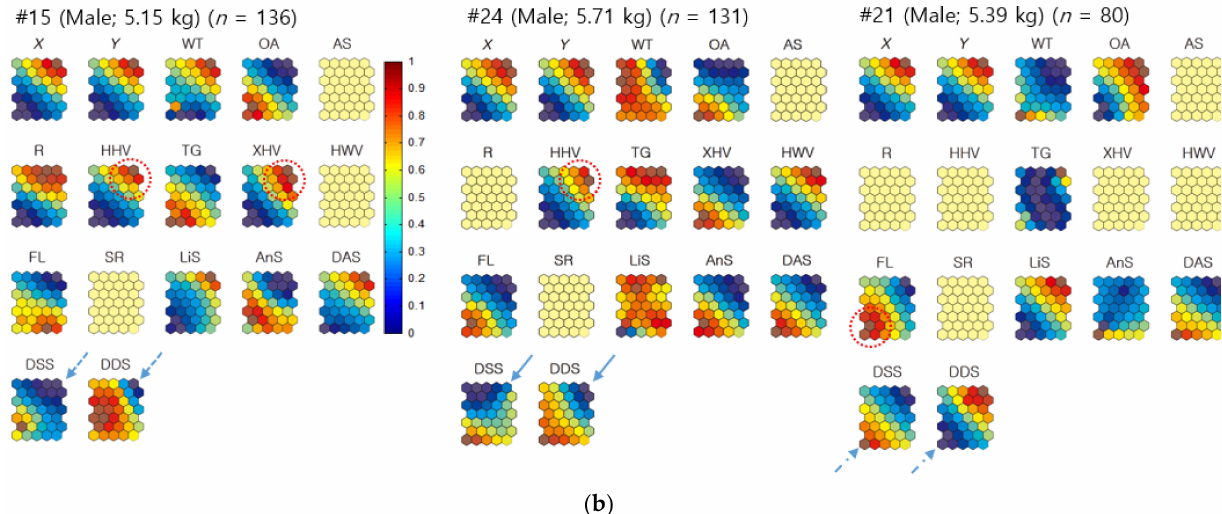
Figure 5. ( a ) Neighbor distances of nutria individuals in association with positions, habitats, plant types, and movement parameters when females were the target individuals for Geo-SOM training ( k = 3). Values in all the component maps were normalized between 0.0 and 1.0, as shown in the vertical bar. Blank component maps had no input value for the variables in each training. Water temperature: WT; open area: OA; artificial structure: AS; road: R; hydric herbaceous vegetation: HHV; tall grassland: TG; xeric herbaceous vegetation: XHV; hydric woody vegetation: HWV; floating-leaved hydrophytes: FL; sex ratio: SR; linear speed: LiS; angular speed: AnS; distances between all neighbor individuals: DAS; distances between neighbors with the same sex: DSS; and distances between neighbors with different sexes: DDS. ( b ) Neighbor distances of nutria individuals in association with positions, habitats, plant types, and movement parameters when males were the target individuals for Geo-SOM training ( k = 3). Values in all component maps were normalized between 0.0 and 1.0, as shown in the vertical bar. Blank component maps had no input value for the variables in each training. Water temperature: WT; open area: OA; artificial structure: AS; road: R; hydric herbaceous vegetation: HHV; tall grassland: TG; xeric herbaceous vegetation: XHV; hydric woody vegetation: HWV; floating-leaved hydrophytes: FL; sex ratio: SR; linear speed: LiS; angular speed: AnS; distances between all neighbor individuals: DAS; distances between neighbors with the same sex: DSS; and distances between neighbors with different sexes: